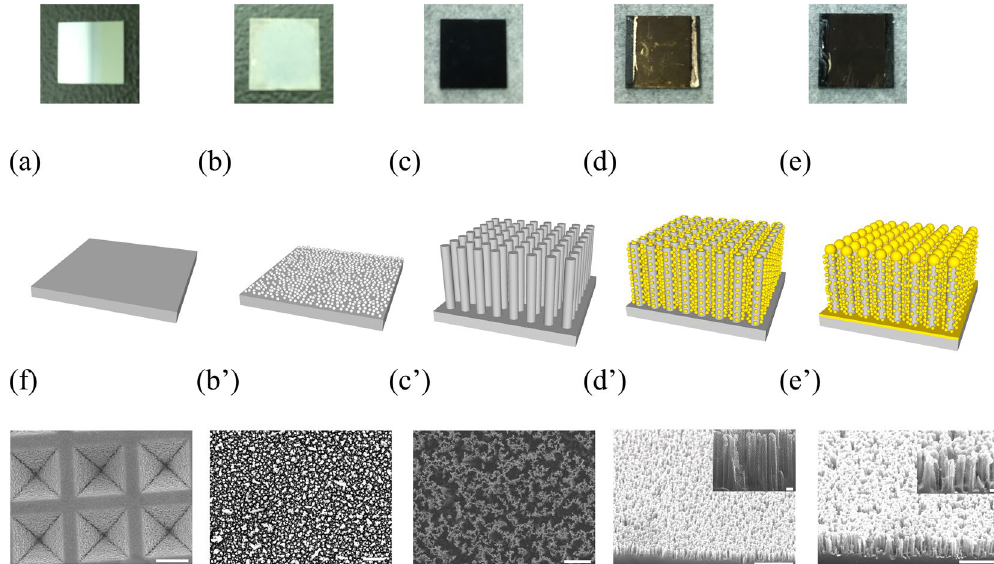
Figure 1. Schematic diagram of experimental process flow ( a ) The cut < 100 > P-type 1 × 1 cm 2 silicon substrate. ( b ) Silicon substrate with silver network as the catalyst for the etching process. The blue region is represented for Ag clusters. ( c ) The SiNWA scaffold for the desired SERS substrate. ( d ) The SiNWA with AuNPs decorated on sidewall by OAD process. ( e ) The SiNWA with AuNPs and AuMBP as the desired SERS substrate. ( f ) SEM figure of commercialized SERS substrate (Klarite). It is noted that Figure ( b ’), ( c ’), ( d ’), ( e ’) are the SEM figures corresponded to each steps. (The scale bar represented 1 μ m in the lower magnitude SEM figure and represented 100 nm in the inset higher magnitude